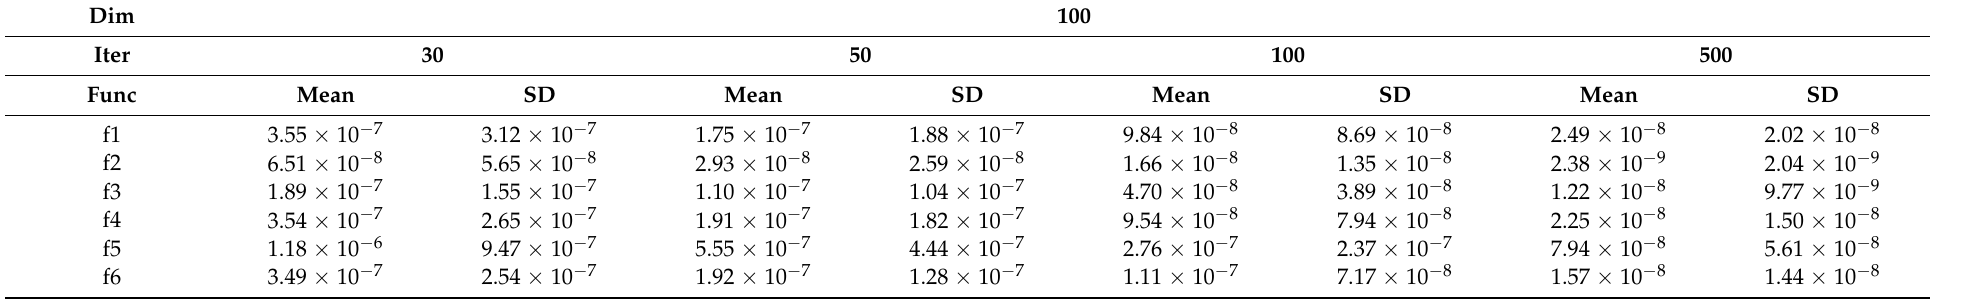
Table 9. DMOA: Results of the experiments for 100